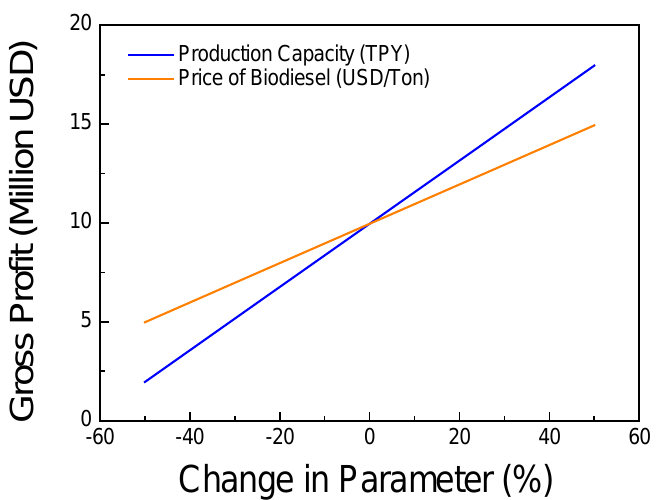
Figure 9. Sensitivity analysis of gross profit for biodiesel production from RSO.